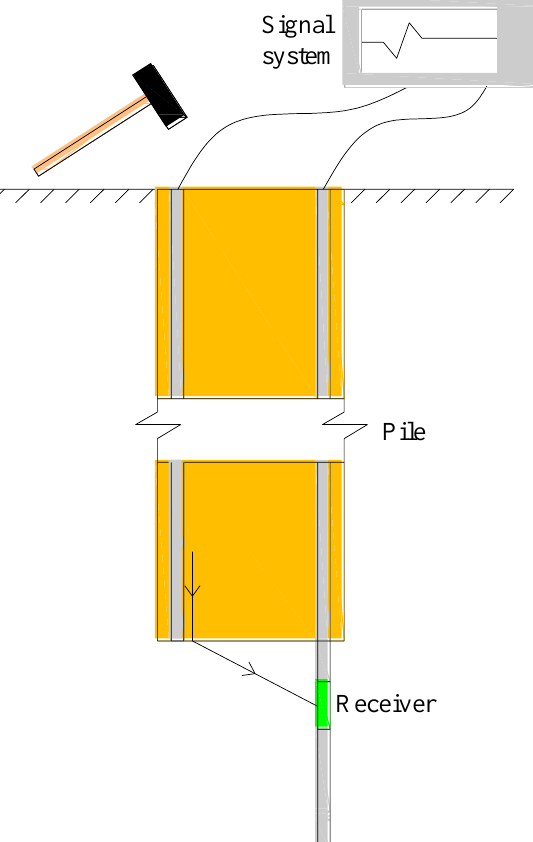
Figure 3. Schematic diagram of the transmitted wave method in the pile.